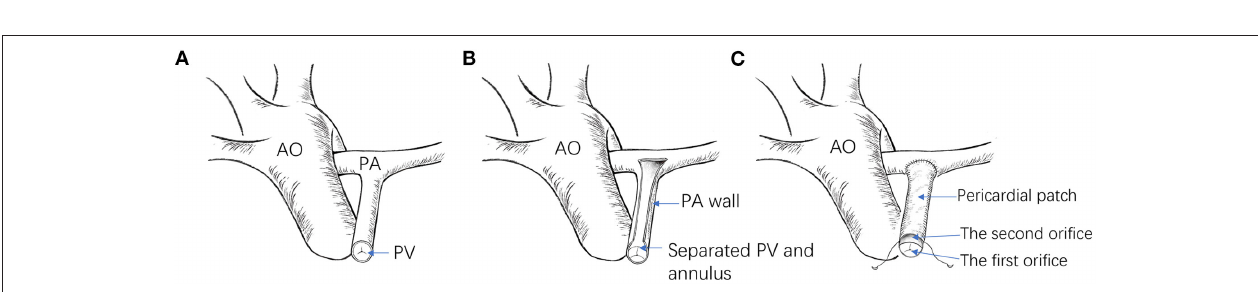
FIGURE 5 | (A) Illustration of the RVOT before reconstruction. (B) The pulmonary artery is incised open, and the partial pulmonary annulus is separated from the pulmonary wall, reserving its integrity. (C) A pericardial patch is used to widen the RVOT (AO, aorta; PA, pulmonary artery; PV, pulmonary valve).